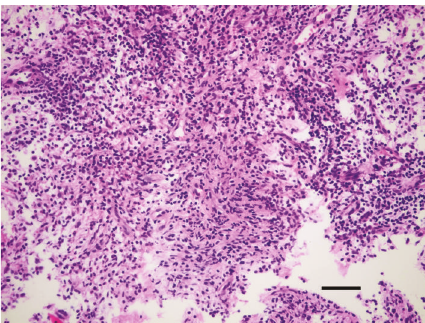
Figure 4: Histological findings of the lesion (hematoxylin eosin staining). The scale bar indicates 50 𝜇